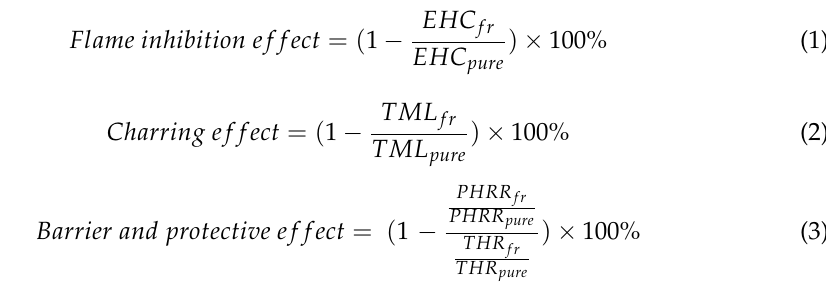
Table 4. Quantitative assessment of three main flame-retardant modes of action. Samples